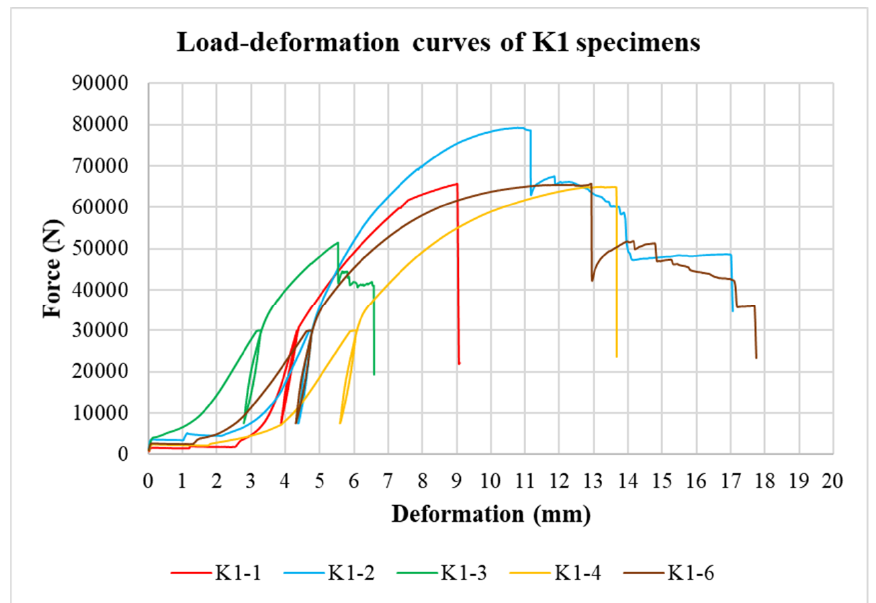
Table 2. Results of the experimental testing of K1 specimens.